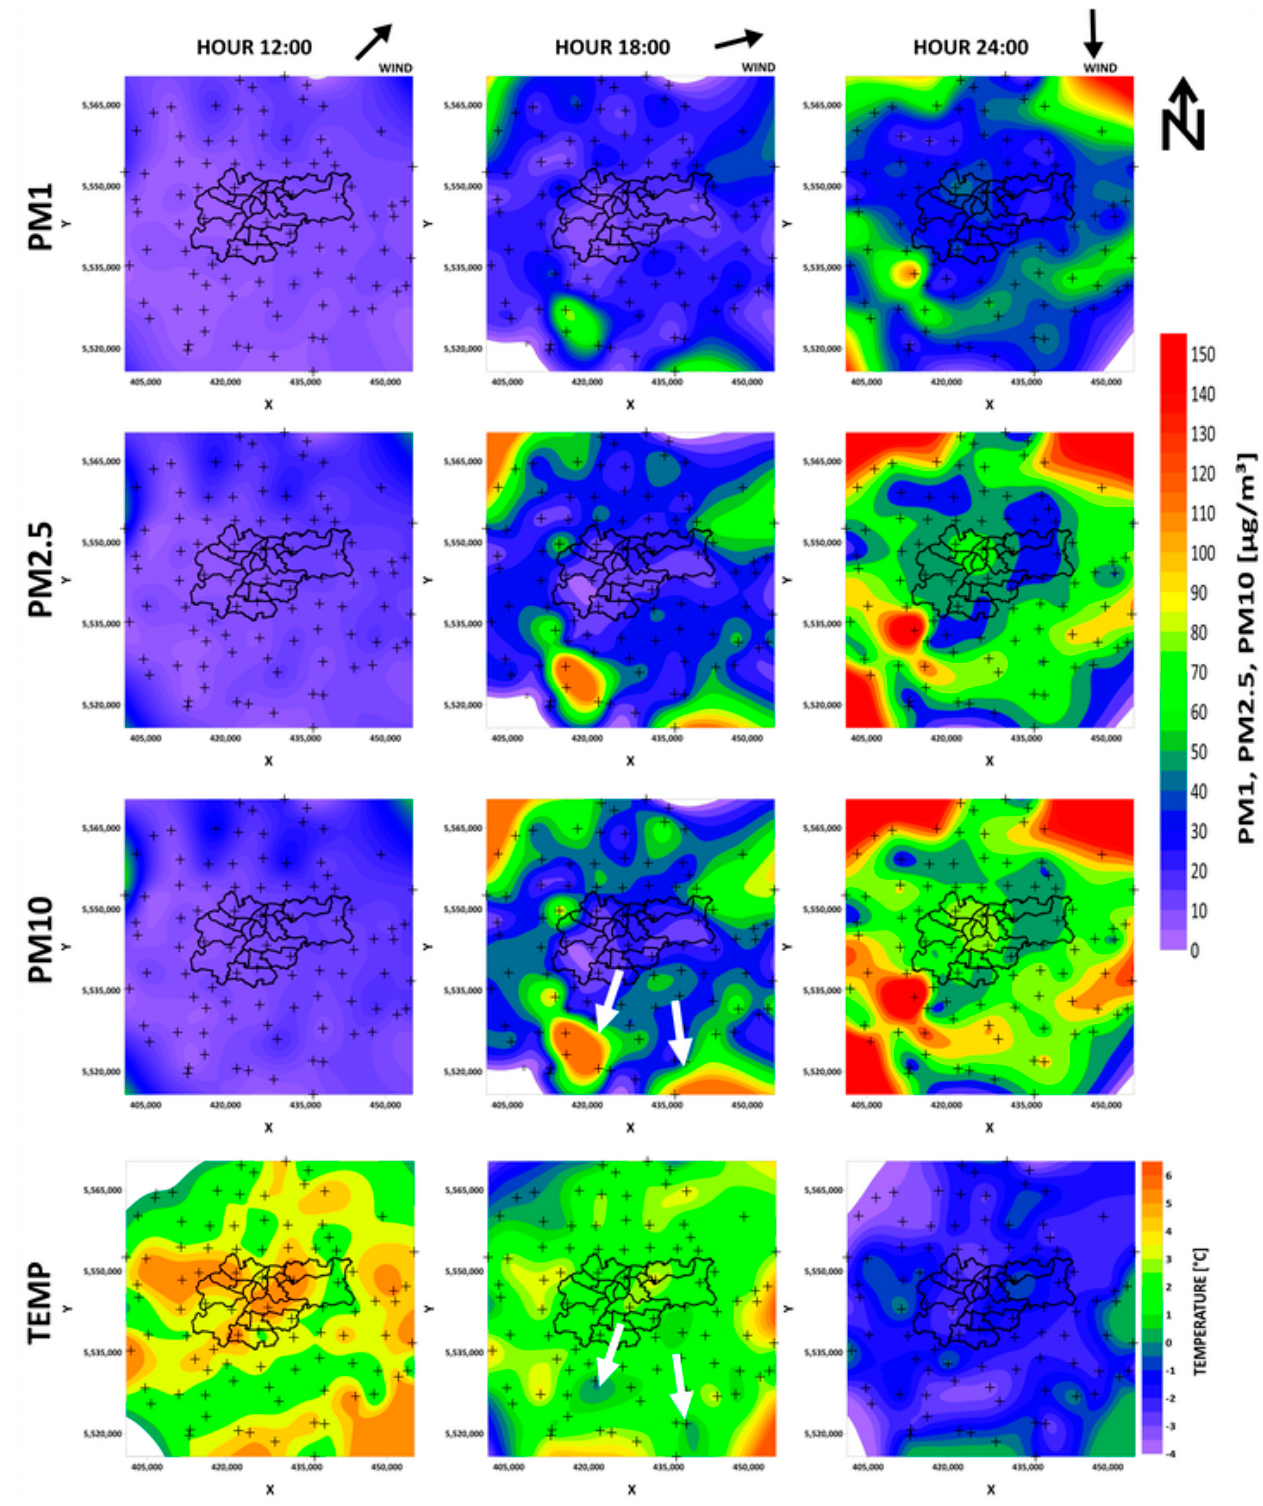
Figure 6. Temperature maps of air pollutions entering (PM1, PM2.5, PM10) Krakow on 18 March 2020. White arrows indicate areas in which the temperature was below the comfort